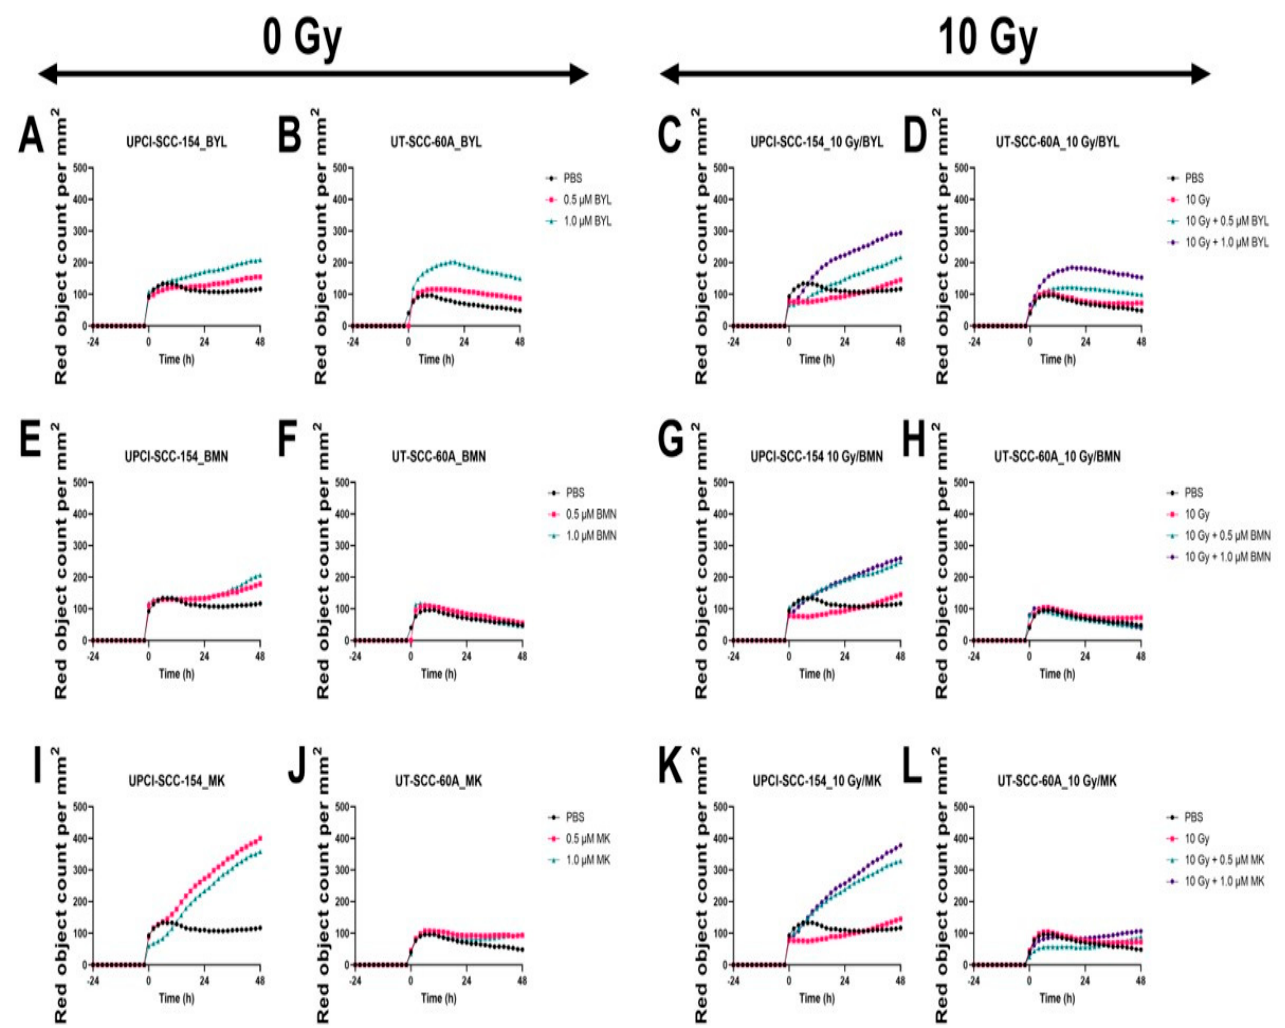
Figure 7. Cytotoxicity response of the HPV+ UPCI-SCC-154 and HPV − UT-SCC-60A cell lines upon treatment with BYL719 with/without (w/wo) 10 Gy ( A – D ), BMN-673 w/wo 10 Gy ( E – H ), or MK-1775 w/wo 10 Gy ( I – L ). The graphs represent one experimental run per cell line. BYL denotes BYL719, BMN denotes BMN-673, and MK denotes MK-1775. 3.5. Proliferation and Cytotoxicity Responses of HPV + UPCI-SCC-154 and HPV − UT-SCC-60A Lines after Combined Treatments with PI3K, PARP, and WEE1 Inhibitors (BYL719, BMN-673 and MK-1775, Respectively) w/wo IR Due to the additive/synergistic of BYL719, BMN-673, and MK-1775 on HPV + UPCI- SCC-154 and HPV- UT-SCC-60A by viability, we investigated their corresponding effects using the same doses used for the viability tests on proliferation and cytotoxicity. 3.5.1. Proliferation Responses of HPV + UPCI-SCC-154 and HPV − UT-SCC-60A Lines after Exposure to PI3K, PARP, and WEE1 Inhibitors BYL719, BMN-673, and MK-1775 in Different Combinations w/wo IR Cell confluence was followed for 72 h after treatment with 0.5 µ M or 1.0 µ M of either BYL719, BMN-673, and MK-1775 in different combinations w/wo 10 Gy on the UPCI-SCC- 154 and HPV − UT-SCC-60A lines. Compared to PBS, combinations of BYL719/BMN-673 BYL719/MK-1775, and BMN-673/MK1775 all had some effect on the cell confluence on both cell lines, while the effects of adding 10 Gy to the inhibitor combinations only provided marginal additional efficacy on cell confluence (Figure